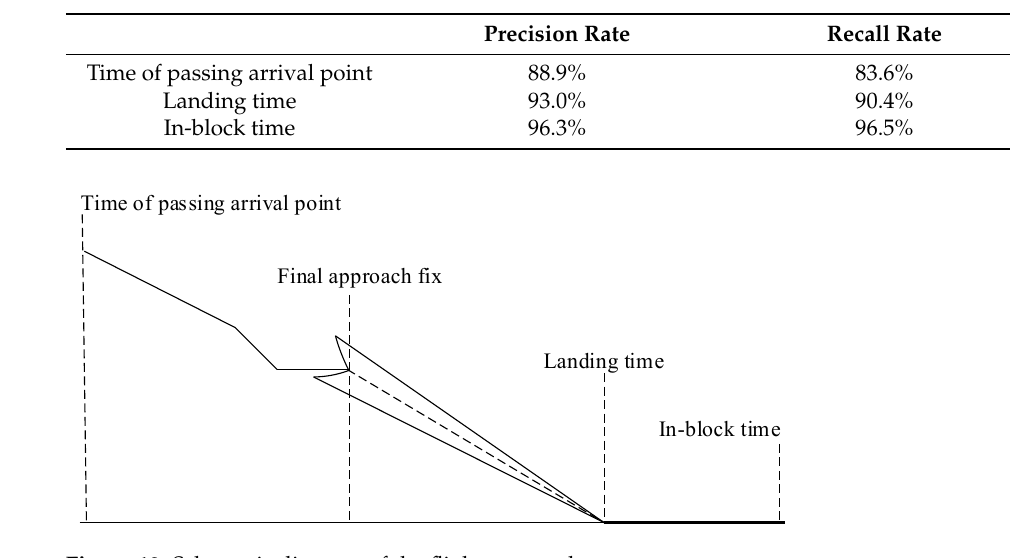
Figure 11. ROC graphs for the three phrases. Figure 10 shows the comparison of the recognition rate of delayed flights using only the XGB-DM model and using both the XGB-DM model and the imbalanced data classifi- cation model. As can be seen from the Figure 12, compared with the delay prediction us- ing only the XGB-DM model, the inclusion of the imbalanced data classification model results in a greater increase in the recognition rate of delayed flights in all three phases, from a low of 51.3% to 83.6% in phase 1 and from a high of 72.1% to 96.5% in phase 3.